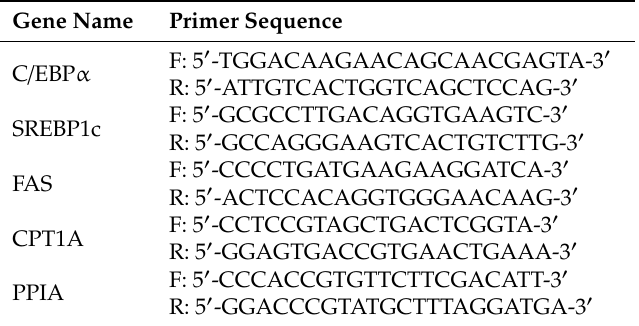
Table 1. Primers used for the analysis of gene